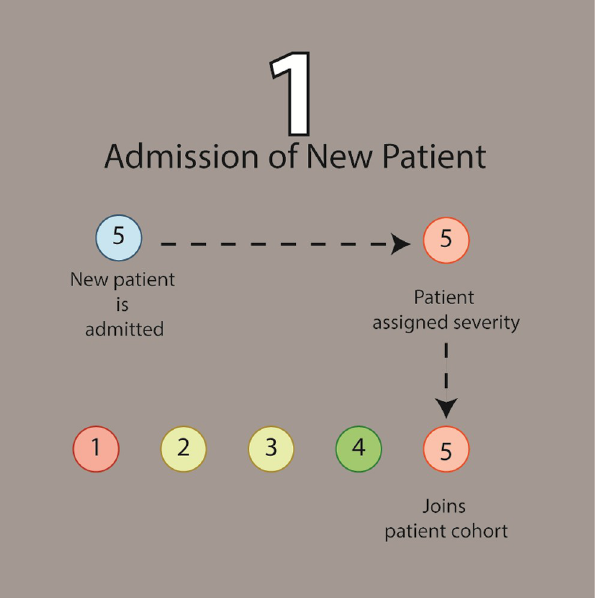
Fig 1. Schematic of the first step in the algorithm—the creation and admission of a new patient (blue) to the simulated ward with a high probability of mortality (red), a moderate probability of mortality (orange and yellow), or low probability of mortality